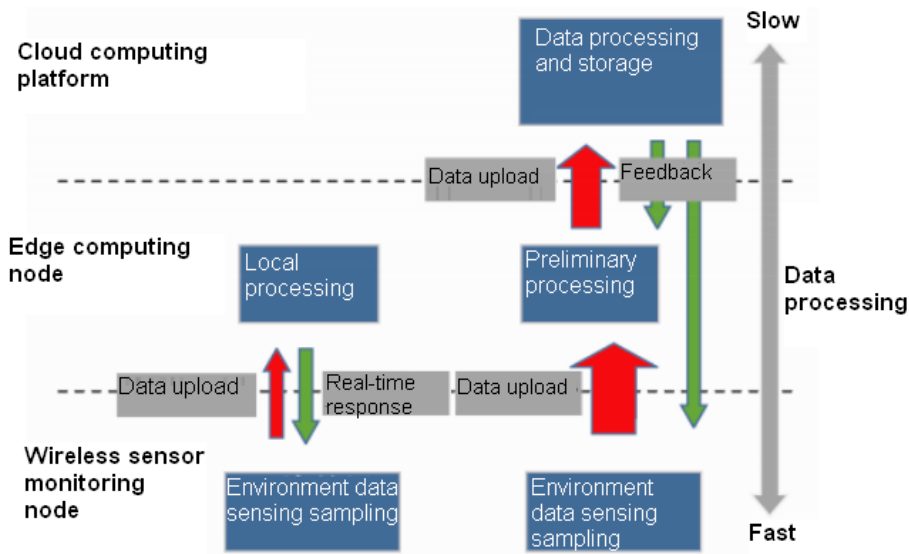
Figure 1. The monitoring system for crop diseases and insect pests.